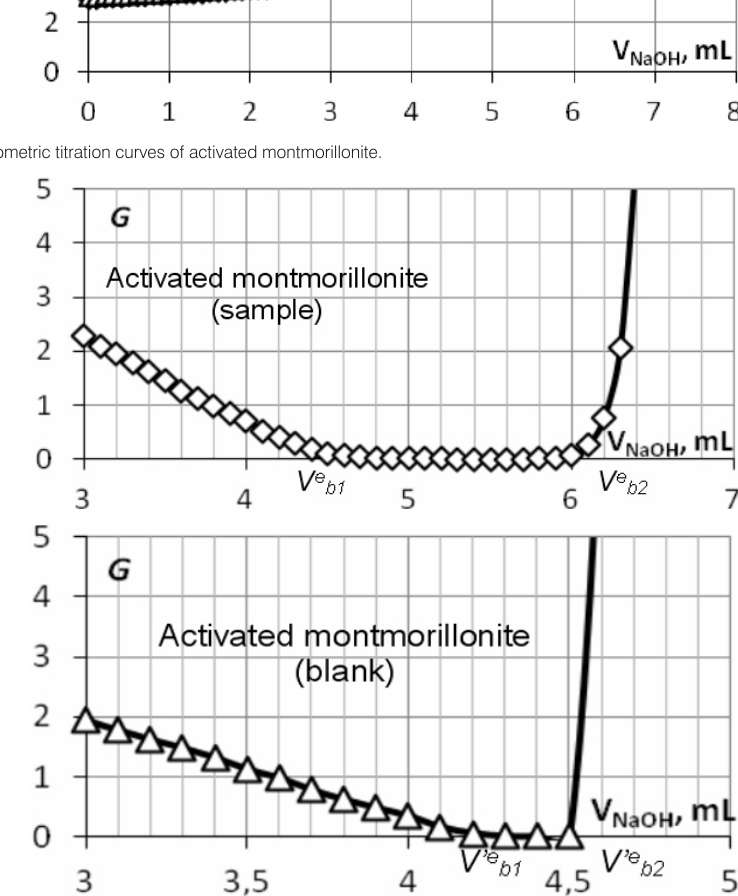
Figure 2. Gran plots for potentiometric titration of activated